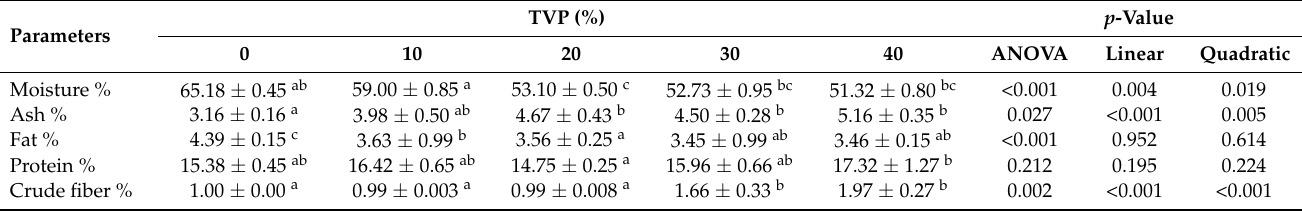
Table 2. Proximate chemical composition of beef patties replaced with different levels of